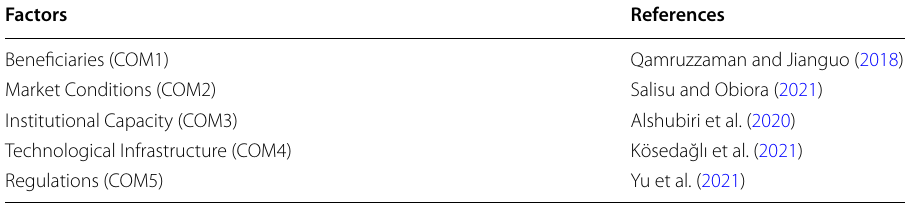
Table 4 Competencies for financial innovation